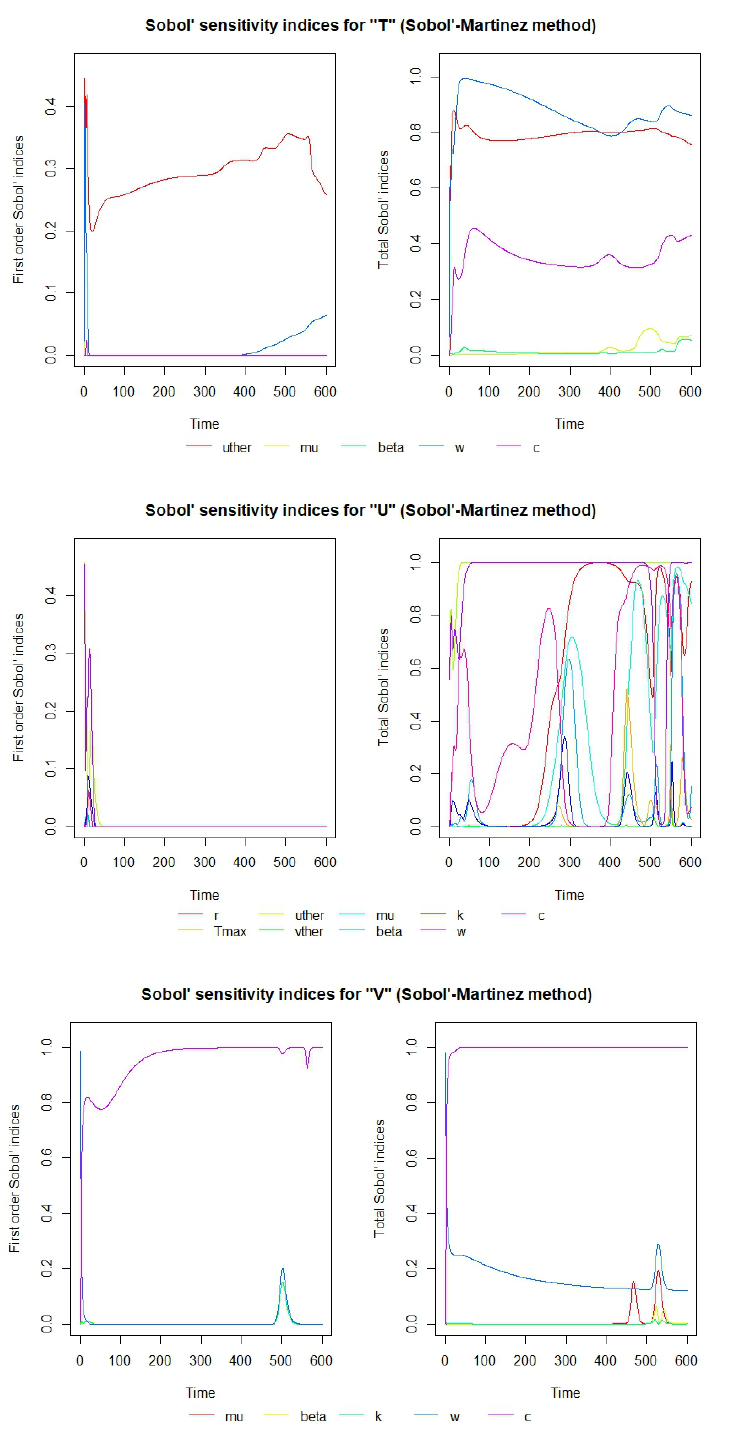
Fig. 6. Sensitivity Analysis of HIV with RTI and PI